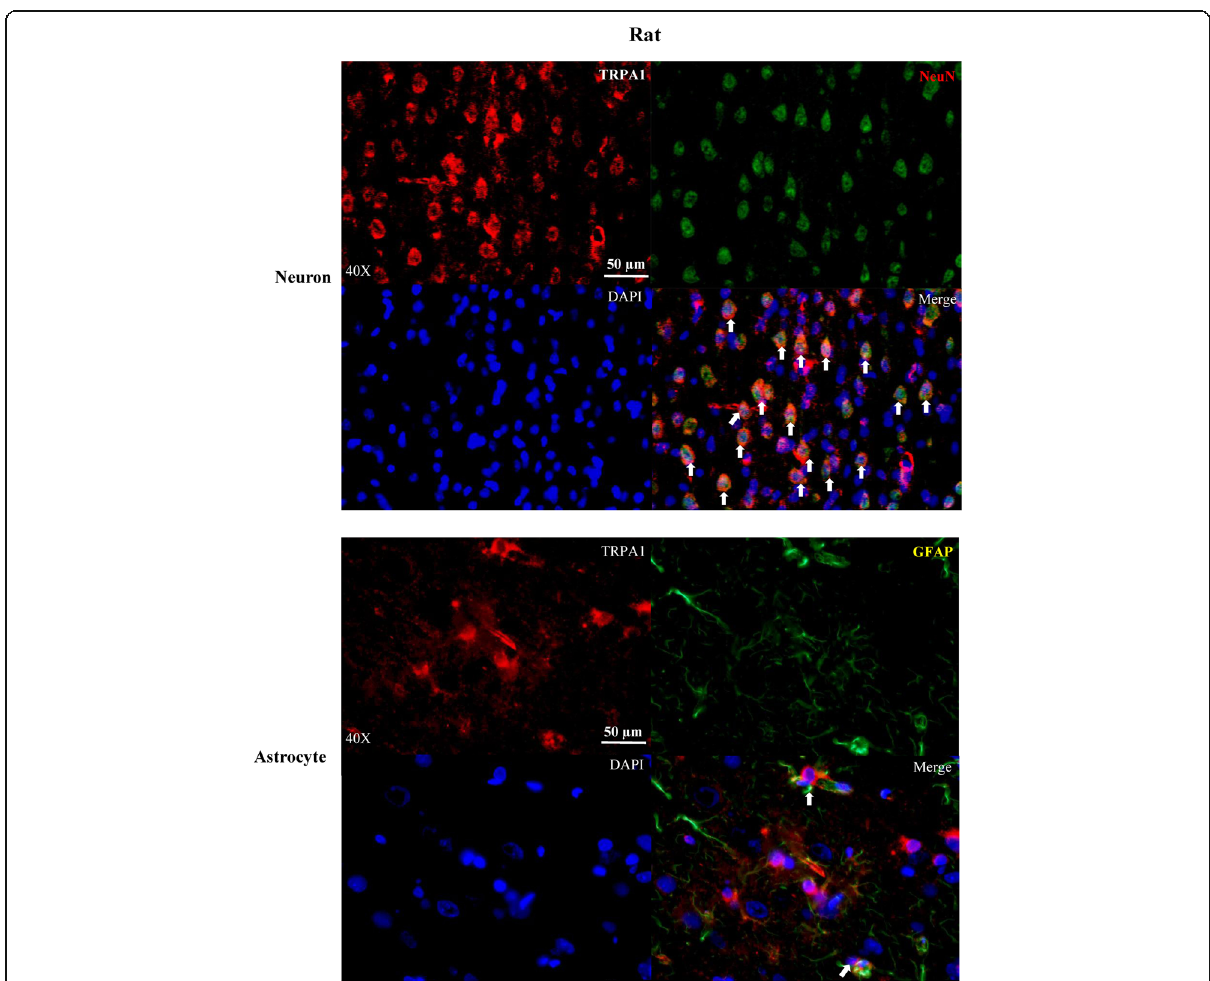
Fig. 1 Representative images showing immunohistochemistry detection of TRPA1 expression in neurons and astrocytes of rat cerebral cortex. Double immune-labelling showed TRPA1 expressed in cerebral cortical neurons (upper panel, white arrows) and astrocytes (lower panel, white arrows). DAPI staining indicates nucleus is shown in blue; TRPA1 in red, NeuN indicates neurons or GFAP indicates glial cells shown in